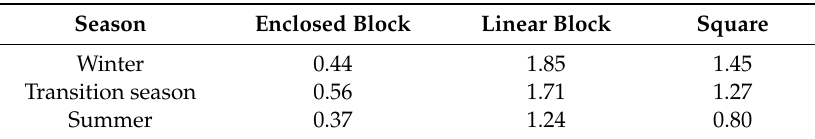
Table 3. Average wind speed (m / s) of each space form. Season Enclosed Block Linear Block